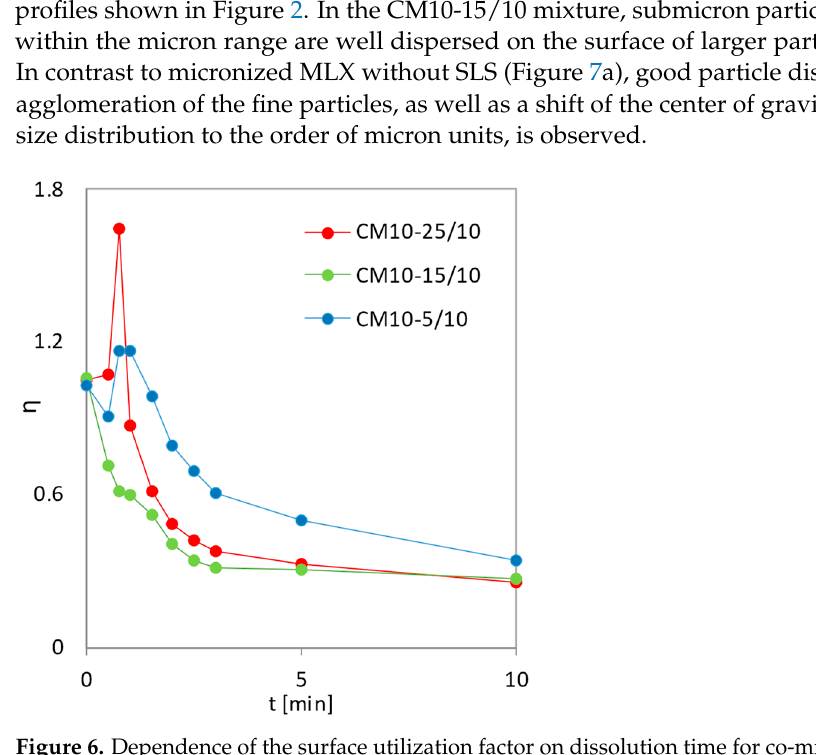
Figure 6. Dependence of the surface utilization factor on dissolution time for co-milled mixtures with varying compositions. Co-milled MLX with 10 mm balls for 10 min; 5, 15, and 25 wt.% SLS.